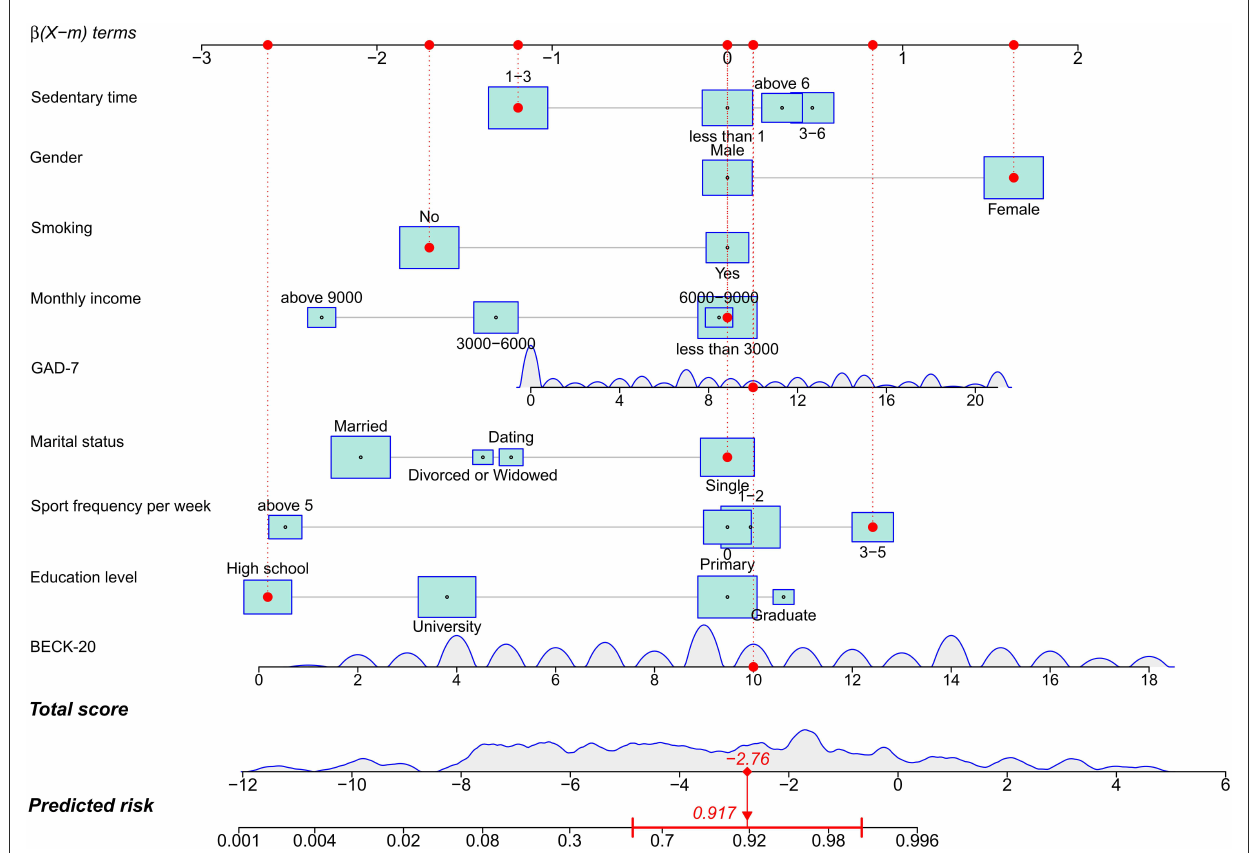
FIGURE2 A nomogram to predict risk of self-poisoning. The red dot in each characteristic in the supplied case showed the case’s current condition. For instance, the red dot was placed at the “No” box because the case was not a smoker. To determine a unique score for the feature, a line was drawn upward from the box to the score axis. All nine features were combined to create the final score ( − 2.76). We were able to determine the patients’ final suicide risk (91.7%) by drawing a line downward to the projected risk